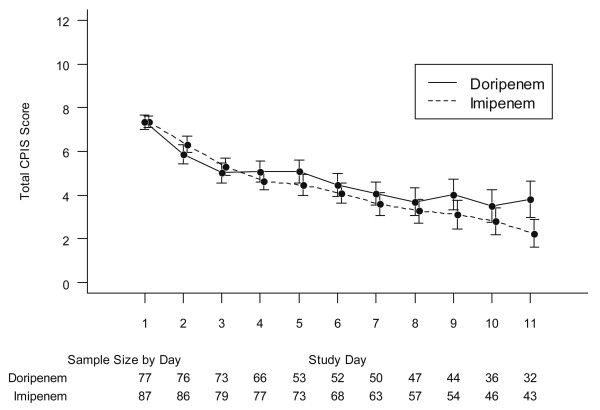
Mean Clinical Pulmonary Infection Scores (CPIS) for the MITT treatment groups during antibiotic therapy. Error bars displayed are based on the 95% confidence interval around the means. As there is significant dropout over time, as can be seen by the available sample sizes at the bottom of the figure, the results have to be interpreted with caution. Nevertheless, the curves suggest that the patients' improvement is similar for the two treatment arms up to Day 8 (the last day of active doripenem treatment), where after the decreasing trend is continued for the subjects in the Imipenem-cilastatin arm (who receive active treatment up to Day 11), but remains stable for subjects in the doripenem arm (who receive only placebo from Day 9 up to Day 11).